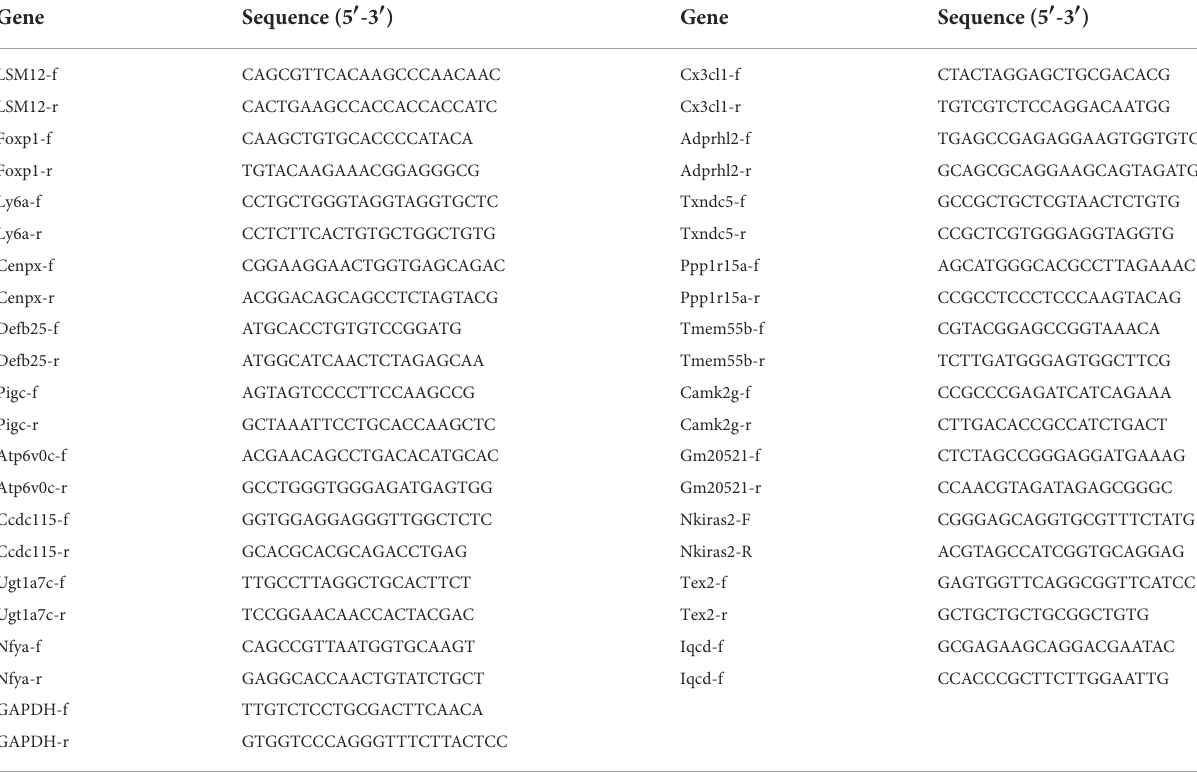
TABLE 1 Primer sequences used in the